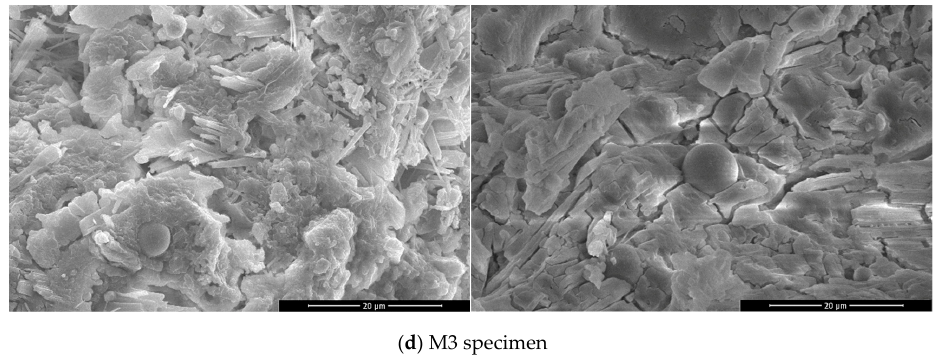
Figure 6. Scanning electron microscopy (SEM) image of MKPC mortar mixed with mineral mixed materials.